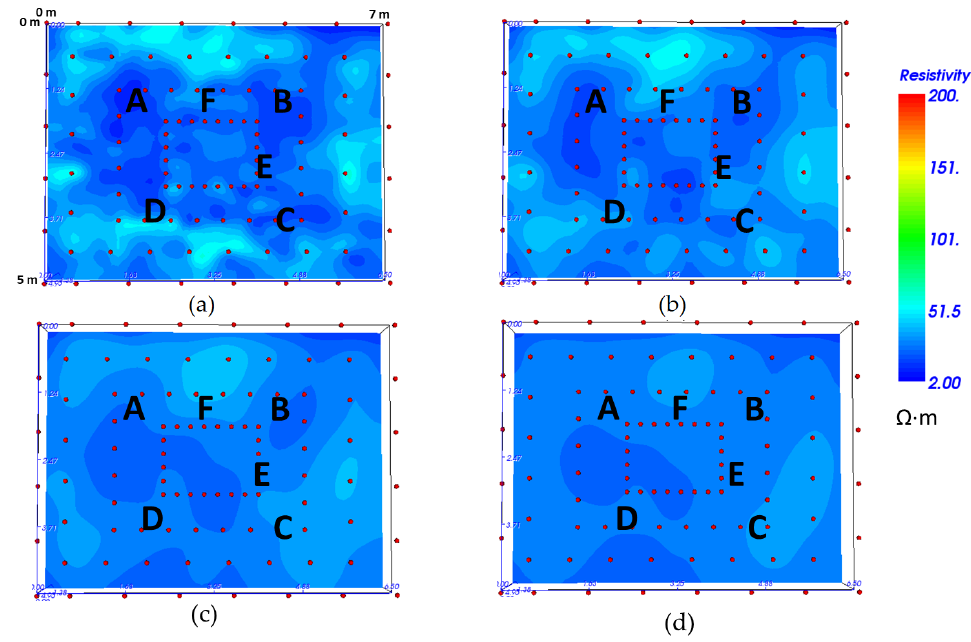
Figure 11. 3D loop – loop ERT depth-slices at 0.25 m ( a ), 0.45 m ( b ), 0.70 m ( c ), and 1.00 m ( d ) in WL2. In WL1 (Figure 12), the high water content does not permit the identification of elec- trical anomalies associated to the buried structures in any slices.